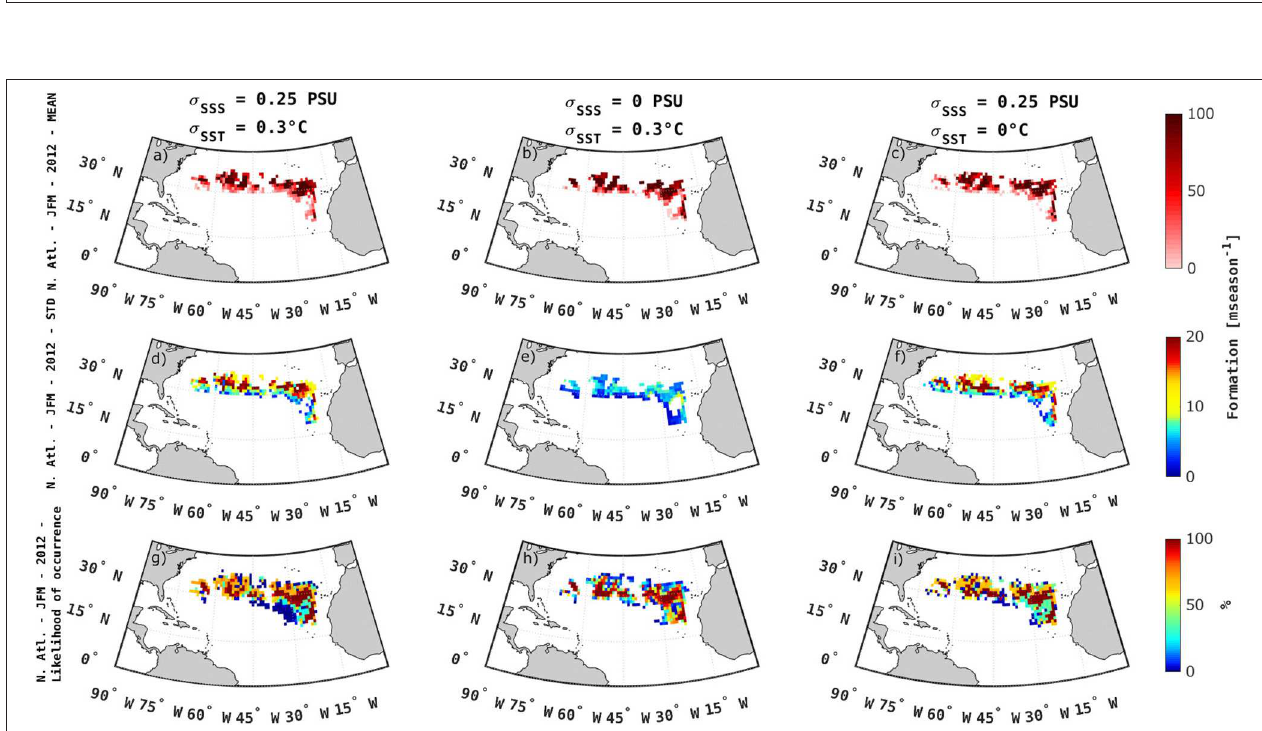
FIGURE 13 | Mean (a–c) and standard deviation (d–f) of formation in geographic space after 500 Monte-Carlo realisations during the winter months (JFM) in 2012 over the North Atlantic, as well as the uncertainty in the geographic distribution over the 500 Monte-Carlo realisations (g–i) . The Monte-Carlo simulation was run three times with uncertainties considered in both SMOS SSS and OSTIA SST (first column), only OSTIA SST (second column) and only SMOS SSS (last column).